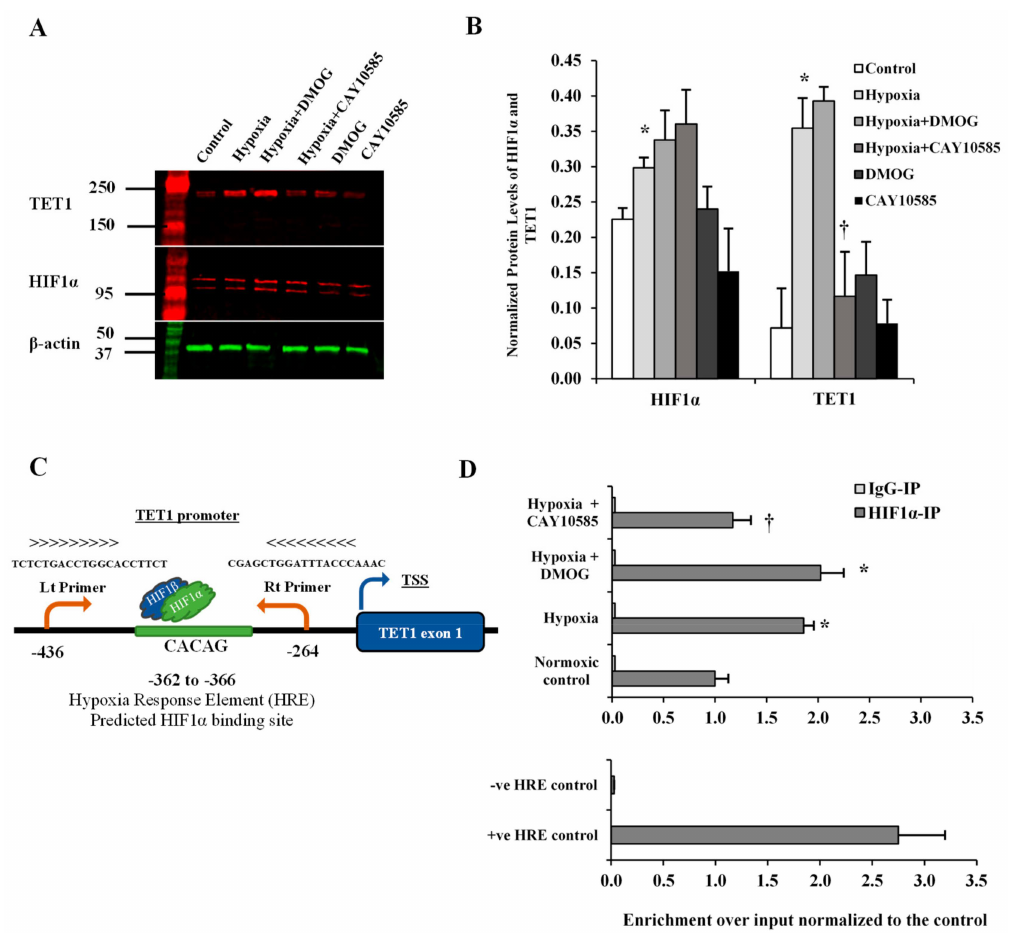
Figure 2. E ff ect of hypoxia on HIF1 α and TET1 expression in di ff erentiated adipocytes. ( A , B ) Western blot analysis and quantification of the normalized signal intensity of HIF1 α and TET1 proteins in response to 24-h hypoxia with either a HIF1 α stabilizer (DMOG) or a HIF1 α inhibitor (CAY10585). ( C ) Illustration that demonstrates the predicted HIF1 α binding site and the location of TET1 primers in the promoter of TET1 gene. ( D ) ChIP-qPCR using a specific antibody against HIF1 α to analyze the presence of HIF1 α protein at the promoter of TET1 gene. ChIP was performed in primary di ff erentiated adipocytes cultured under normal or hypoxic conditions. Normal mouse IgG was used as a negative antibody control. primers, which amplify regions containing and lacking the HRE of PDK1 were used as positive and negative locus control, respectively. Results represent the means ± SD for three independent experiments in triplicates for each treatment (n = 9). (* p < 0.05) for comparison with control. ( † p < 0.05) for comparison with